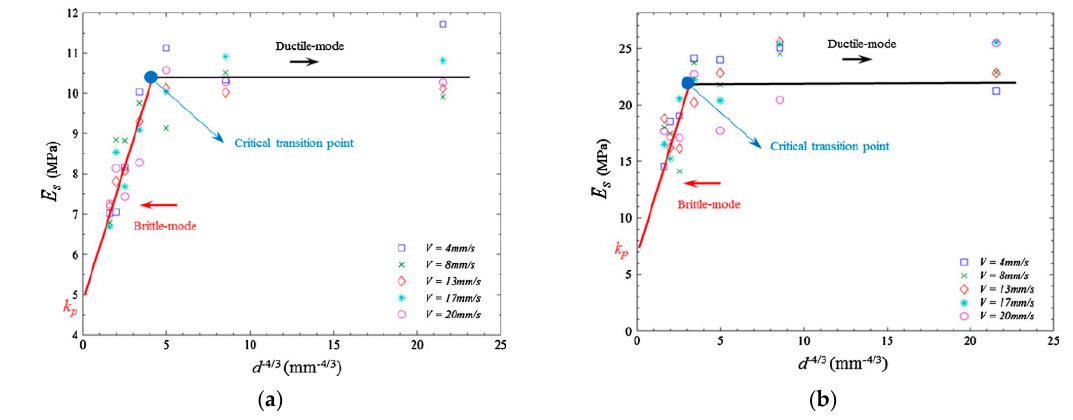
Figure 3. The specific cutting energy values throughout the rock cutting process: ( a ) Tuffeau limestone, ( b ) Savonnières limestone [20]. These graphs show the evolution of the specific energy versus d − 4/3 . The specific energy does not change with the DOC in the ductile mode.